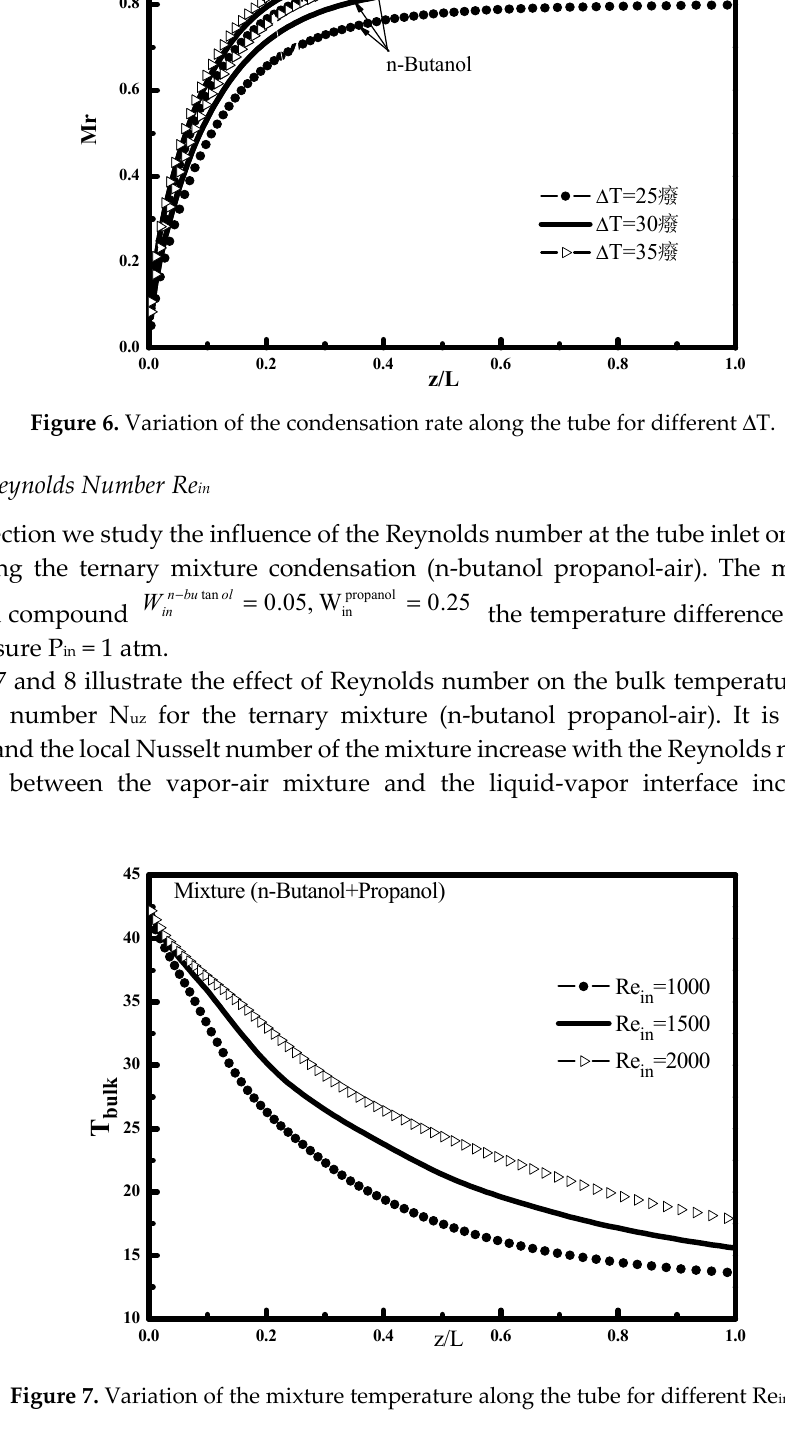
Figure 5. The condensed vapor portion in the case of propanol vapor is more intense than in the case of n-butanol vapor. This observation is confirmed by Figure 4 which shows the bulk mass fraction. For the propanol vapor the concentration declines from W bulk = 0.25 to 0.024 i.e., a decrease in mass fraction of 91% against 0.05 to 0.0093 i.e., with a decrease in mass fraction of 85% for the n-butanol vapor.